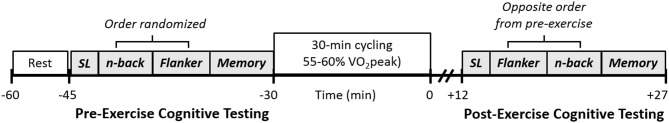
Study design for assessing cognitive function pre and post moderate intensity exercise aerobic exercise. SL, study list.